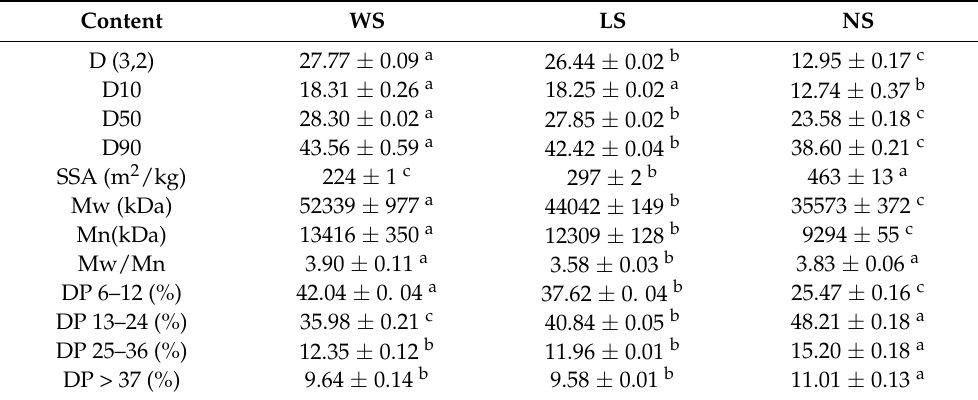
Table 2. Particle size distribution, molecular weight, and the chain length distribution of starch samples extracted by different